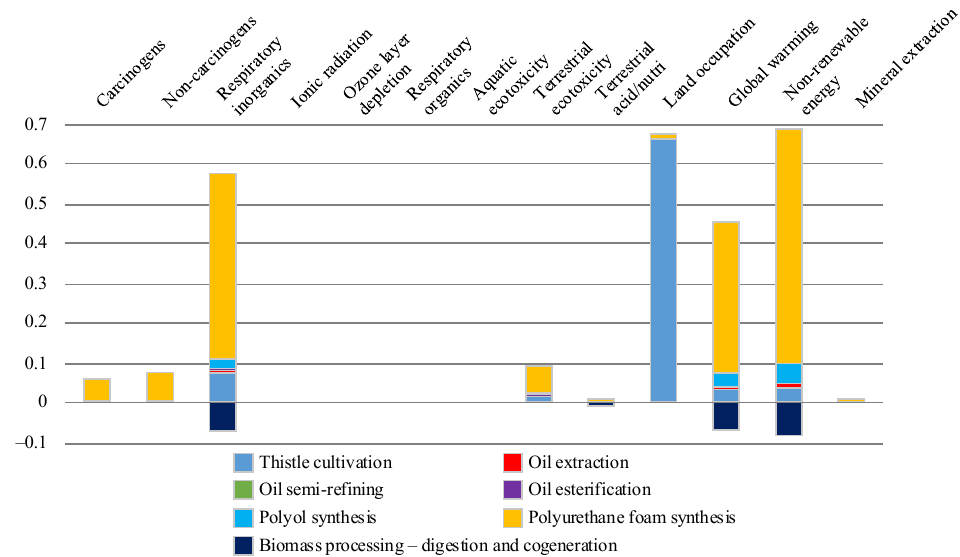
Fig. 4. IMPACT 2002+ midpoint impact categories for the production of 1 kg rigid polyurethane in mPt.